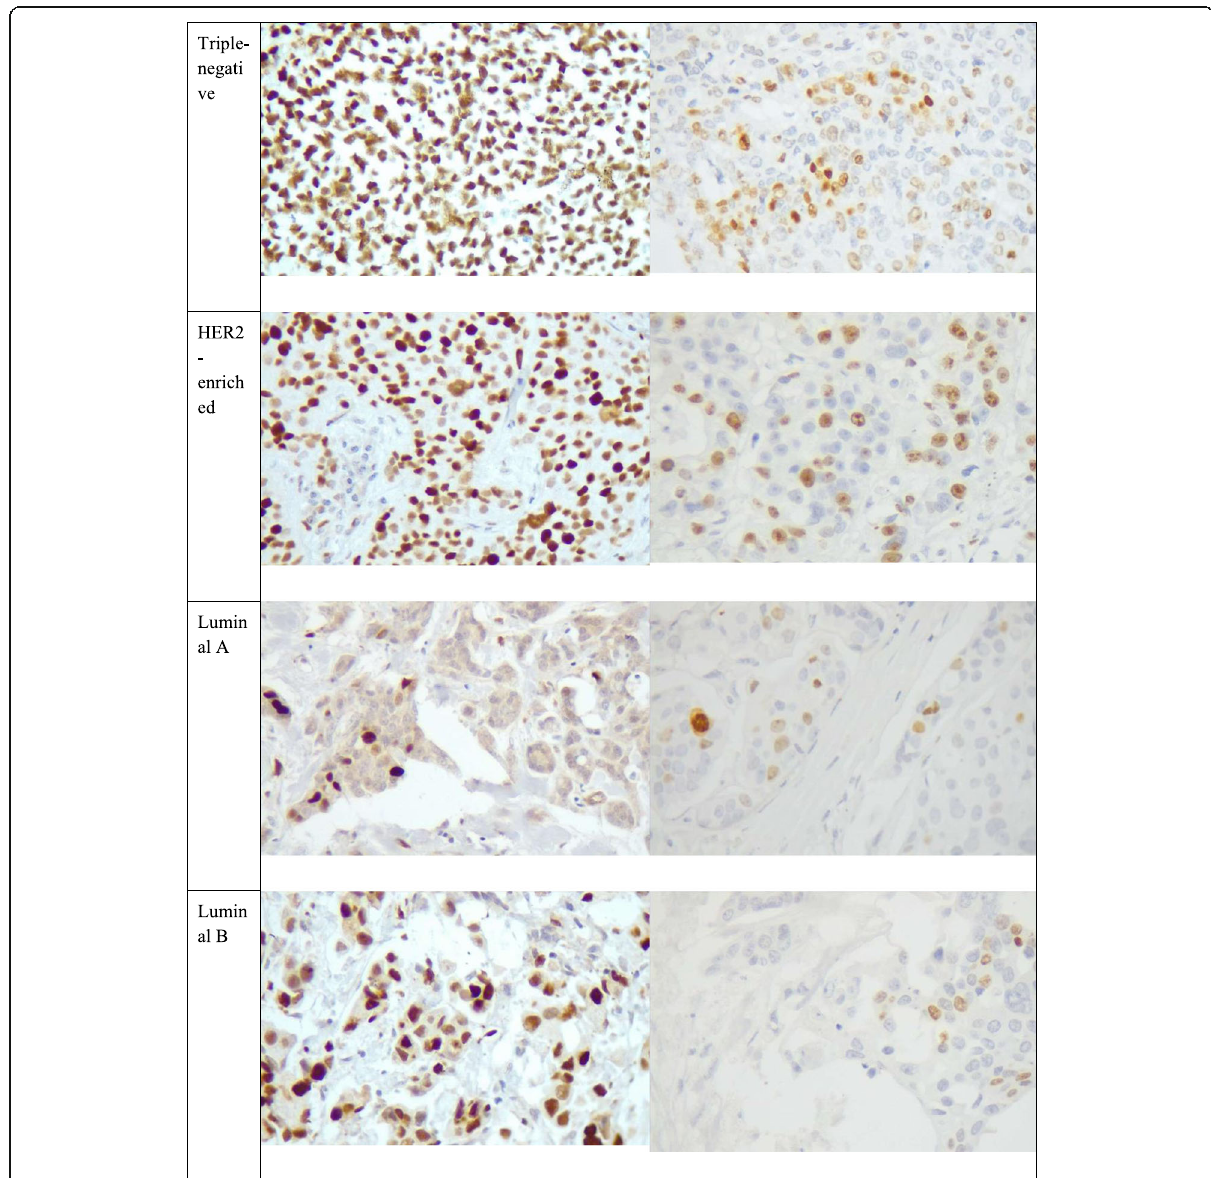
Fig. 1 Comparison of MCM6 and Ki-67 staining of different molecular subtypes of breast cancer. Comparing luminal subtypes, the MCM staining level was significantly higher for the luminal B subtype. In addition, MCM6 and Ki-67 expression levels were both significantly higher in TNBC, compared with luminal A and B